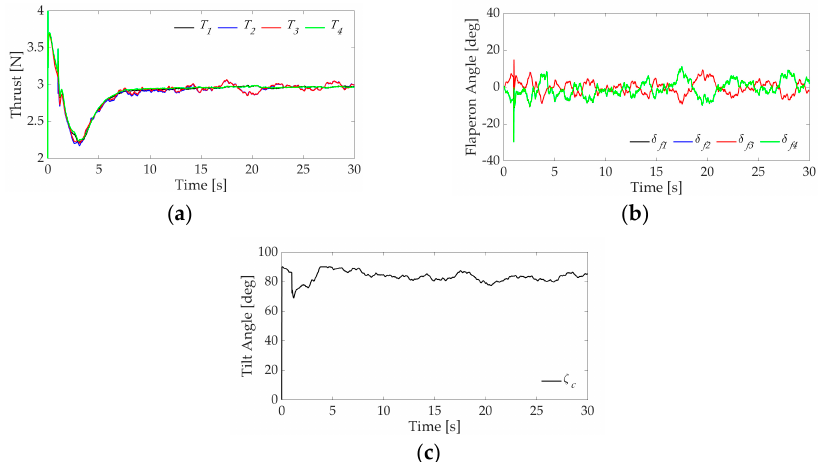
Figure 14. Time responses of control inputs using proposed controller. ( a ) Thrust; ( b ) Flaperon angle; ( c ) Tilt angle.